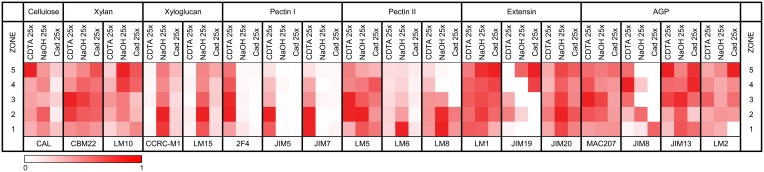
Epitomic heatmap. The results for each antibody are scaled relative to the maximum signal for that antibody. The heatmap is supplemented by Supplementary Figure S2, which shows the actual signals in graph form for each antibody. Pectin I corresponds to homogalacturonan epitopes and Pectin II to rhamnogalacturonans.